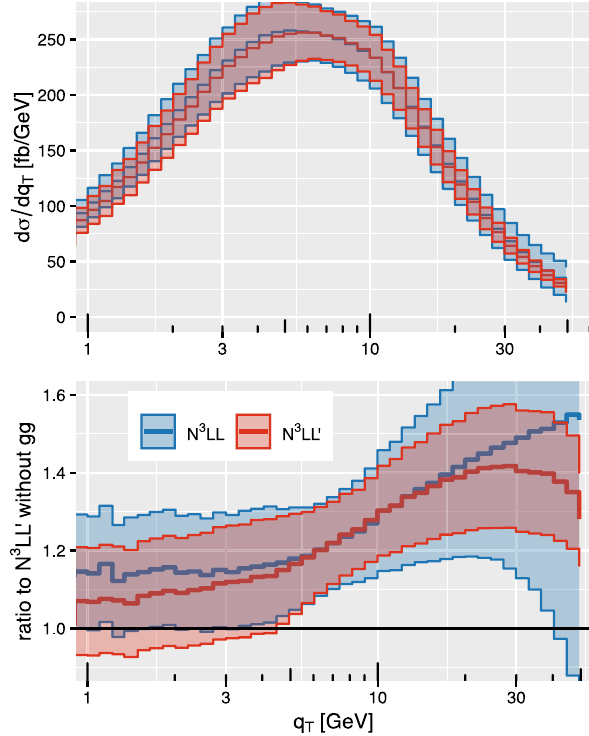
Fig. 3 Resummed q T spectrum without transition function nor match- ing including both q ¯ q and gg channels. Top plot: absolute distributions. Bottom plot: ratio to N 3 LL (cid:2) without gg